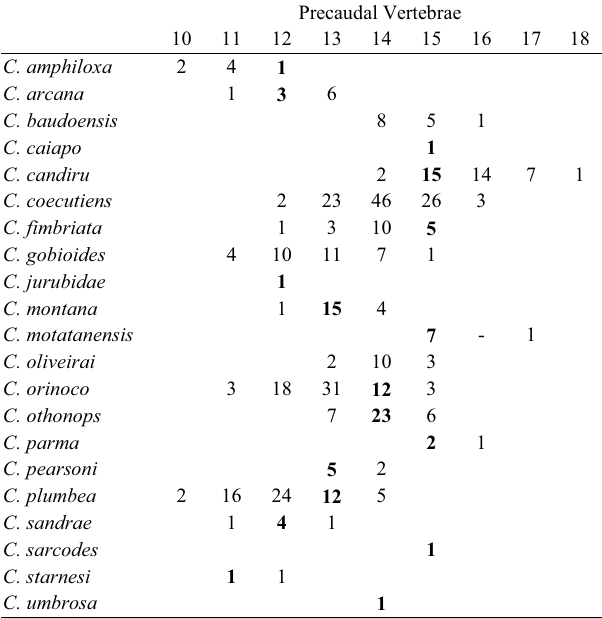
Table 13. Number of specimens of the species of Cetopsis with cited number of precaudal vertebrae. Bold indicates val- ues for holotype or lectotype when